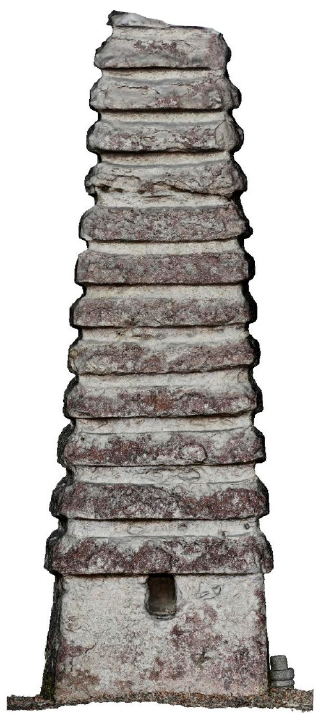
Figure 8. The Rokutanji site.